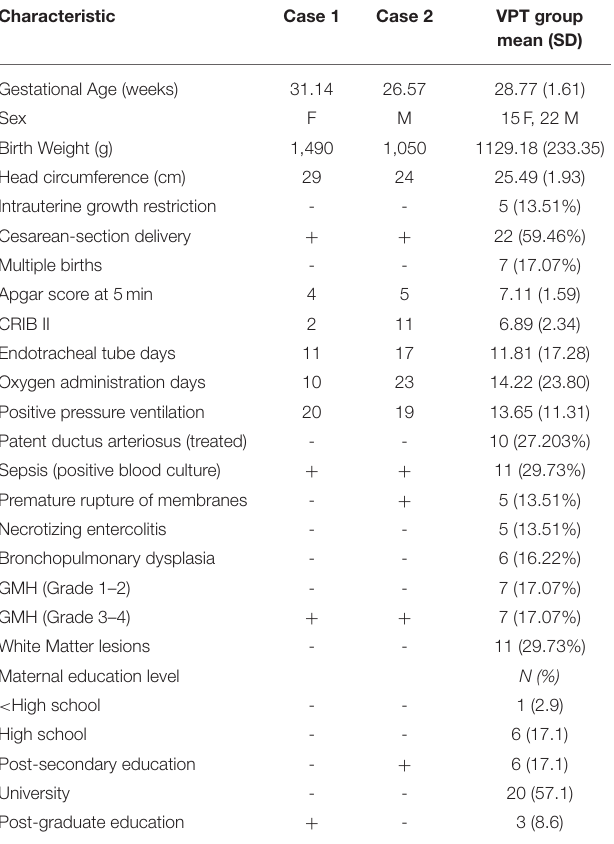
TABLE 1 | Clinical and radiological characteristics of VPT